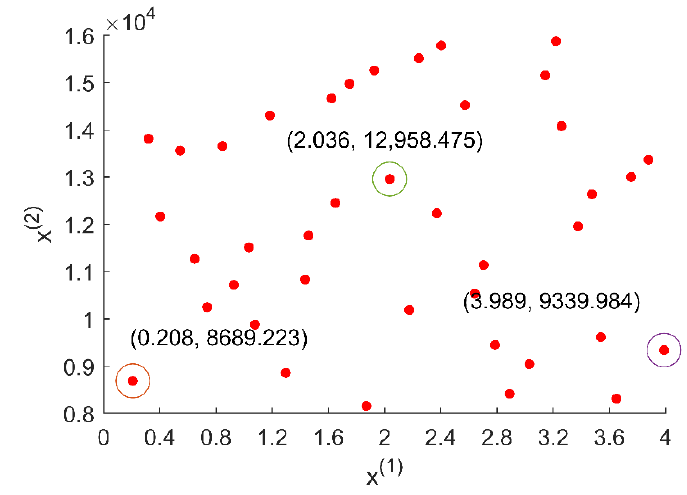
Figure 3. Design of experiments using LHS.